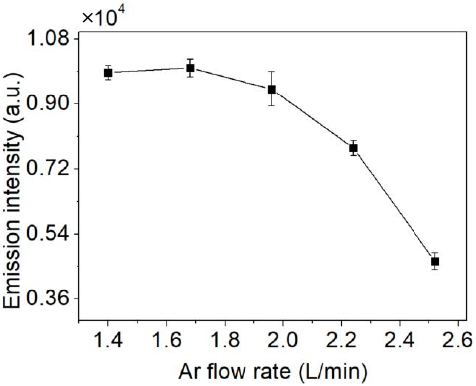
Figure 8. The effect of the Ar flow rate on emission intensity (applied voltage: 5.6 kV, no organic matter and nitric acid, solution flow rate: 2 mL/min).